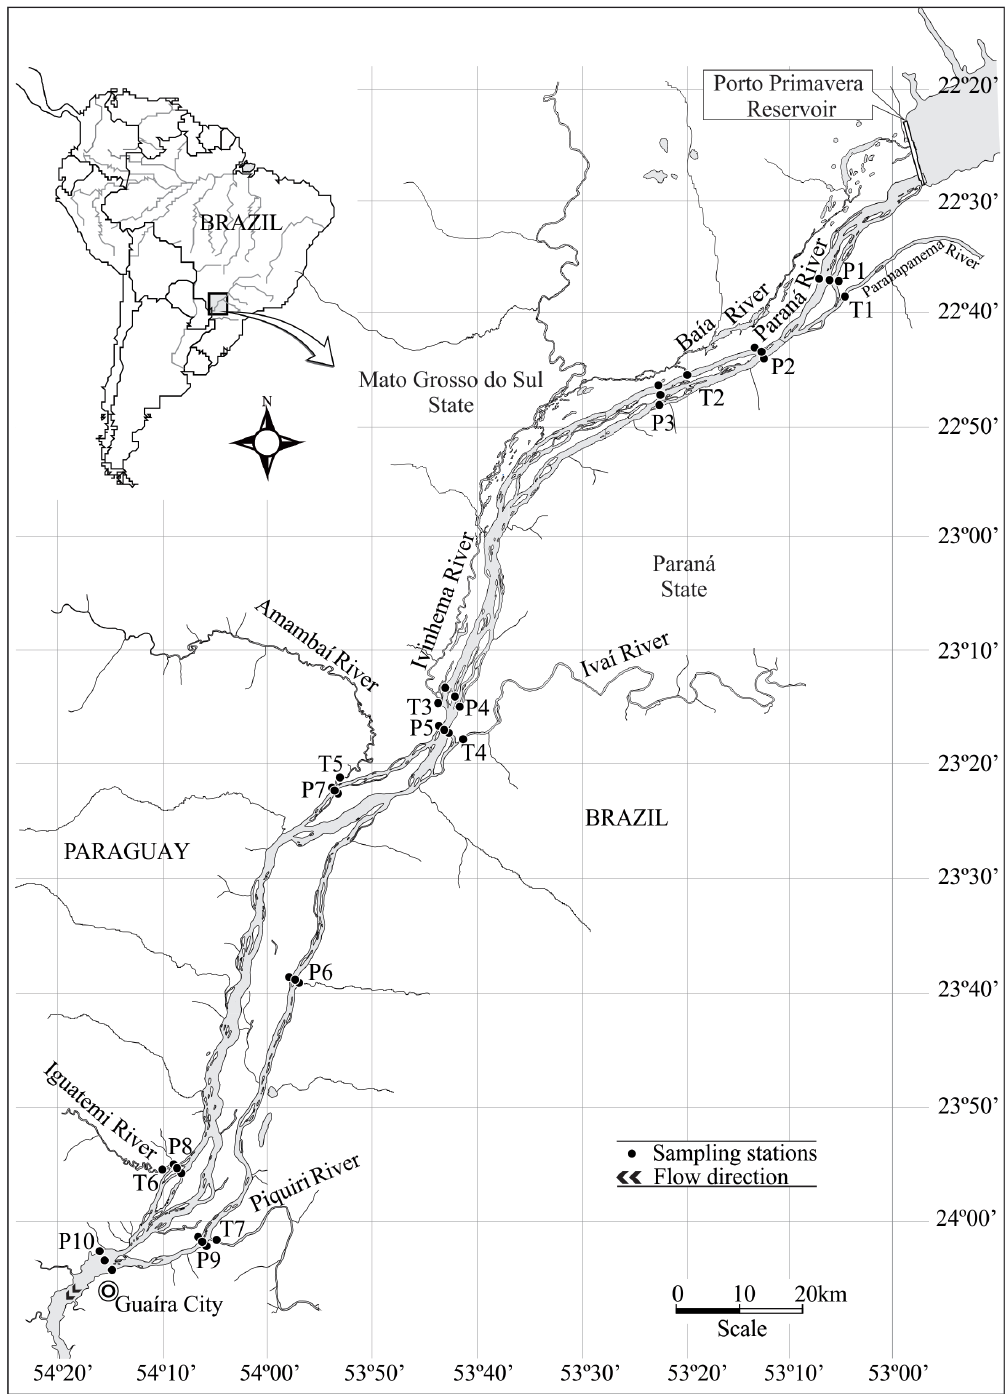
Figure 1. Map showing the sampling stations at the Upper Paraná River considering different distances from the Porto Primavera reservoir P1 to P10 – sampling stations at the right and left margins and at the center of the Paraná River main channel, T1 to T7 are the main tributaries. T1- Paranapanema River; T2- Baía River; T3- Ivinhema River; T4- Ivaí River; T5- Amambaí River; T6- Iguatemi River; T7- Piquiri